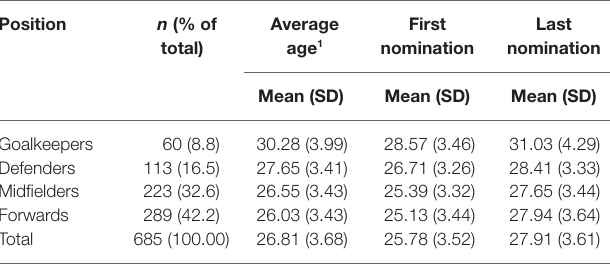
TABLE 2 | Age at nominations across playing positions for retired players. Position n (% of Average total) age